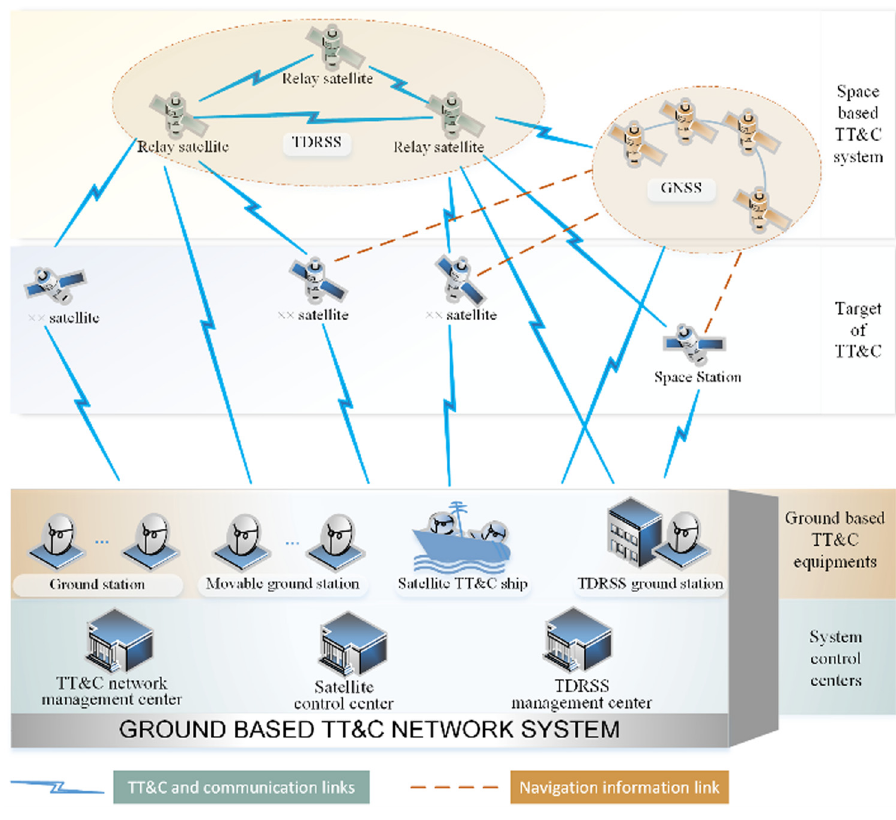
Figure 1: Conceptual diagram of SAGITN.